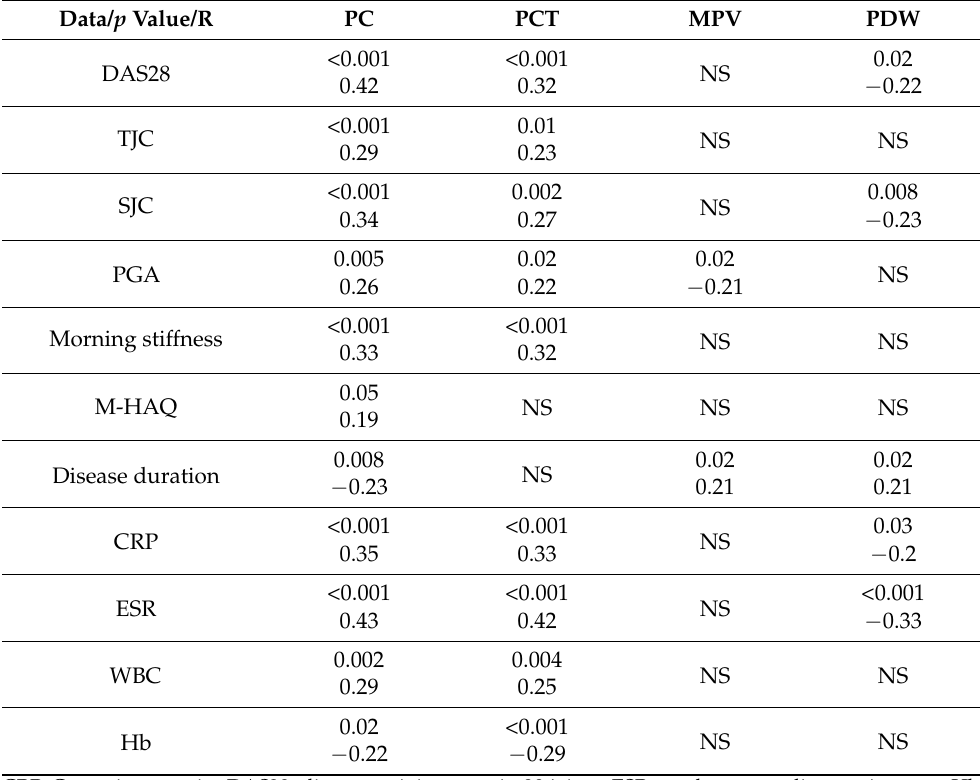
Table 3. Correlations between clinical and laboratory parameters and PIs in patients with